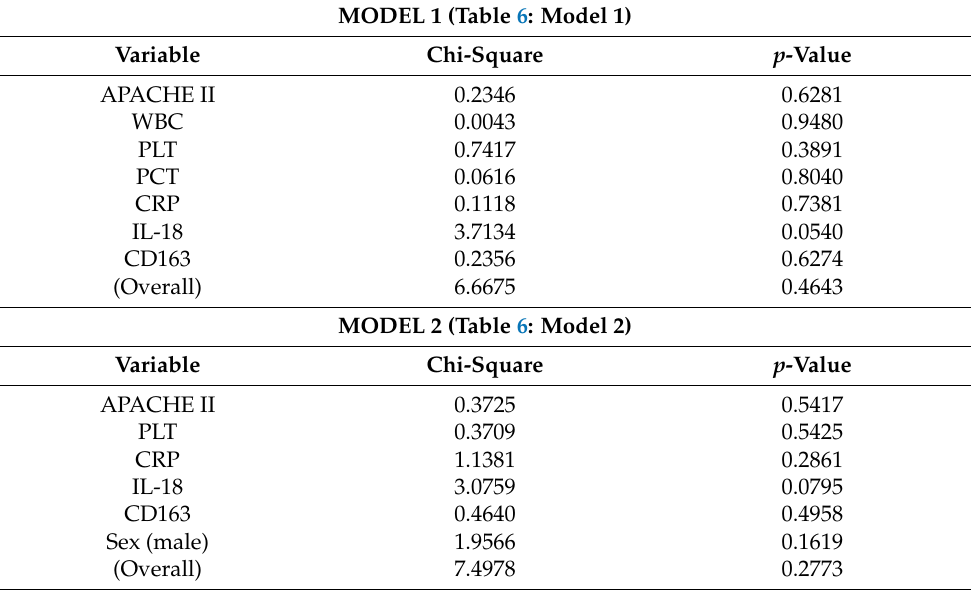
Table A7. The Schoenfeld residual test applied to the two Cox proportional hazards regression